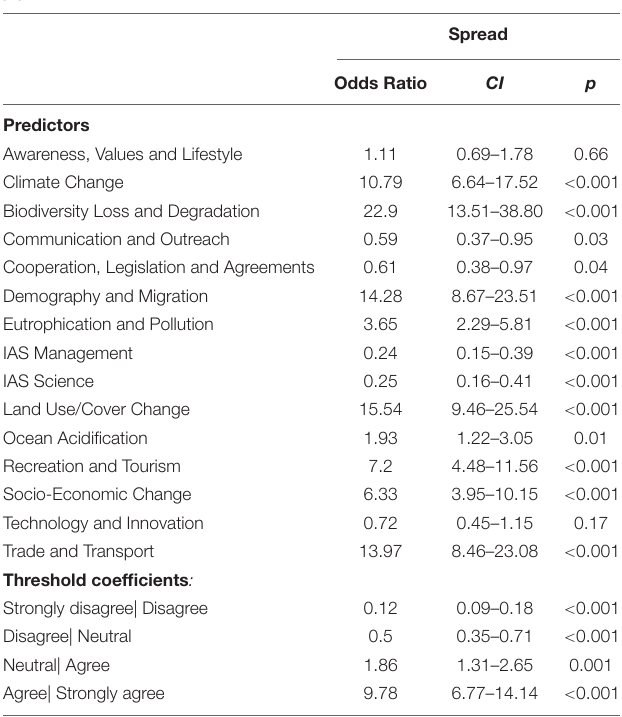
TABLE 2 | Proportional odds models analyzing if the 15 drivers of biological invasions addressed in the survey significantly increase alien species (A) introduction, (B) establishment, and (C) spread on islands in the 21st